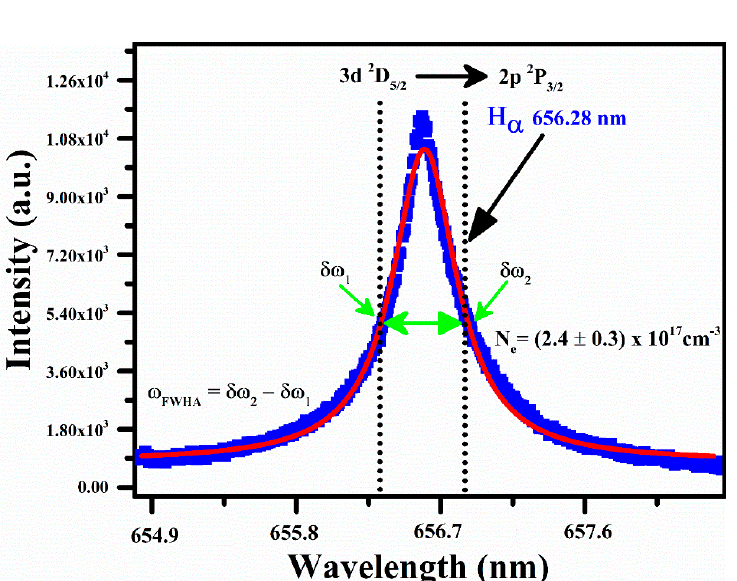
Figure 6 . Stark broadened line profile of hydrogen H α spectral line profile at 656.28 nm through the Voigt fitting.